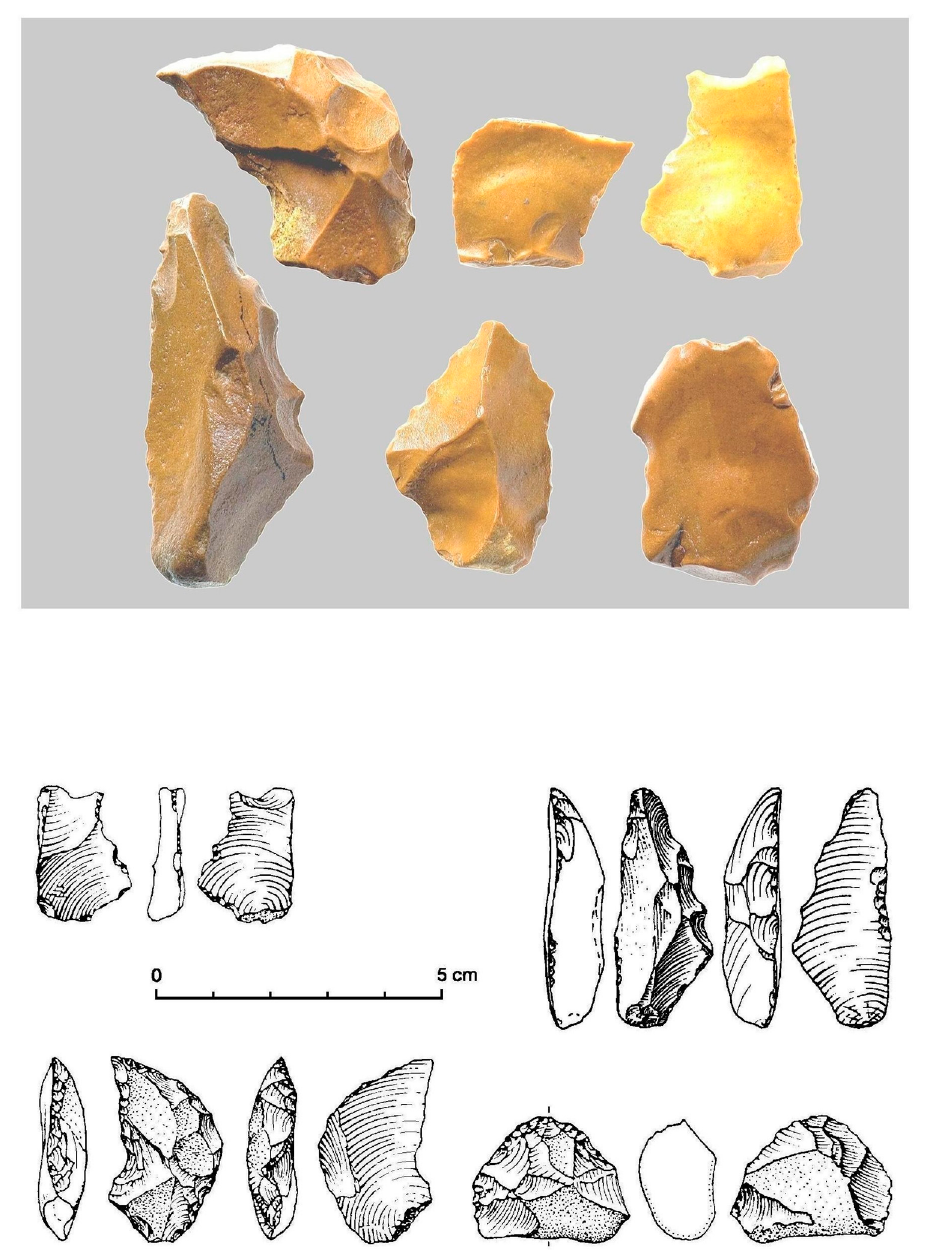
Figure 17. Mauer. Some of the chert artefacts found in situ and/or collected by Hormuth in the first half of the 20th century in the sand pit “Grafenrain“ at Mauer. (Drawings: B. Kaletsch, photo: Reiss-Engelhorn-Museum Mannheim.).